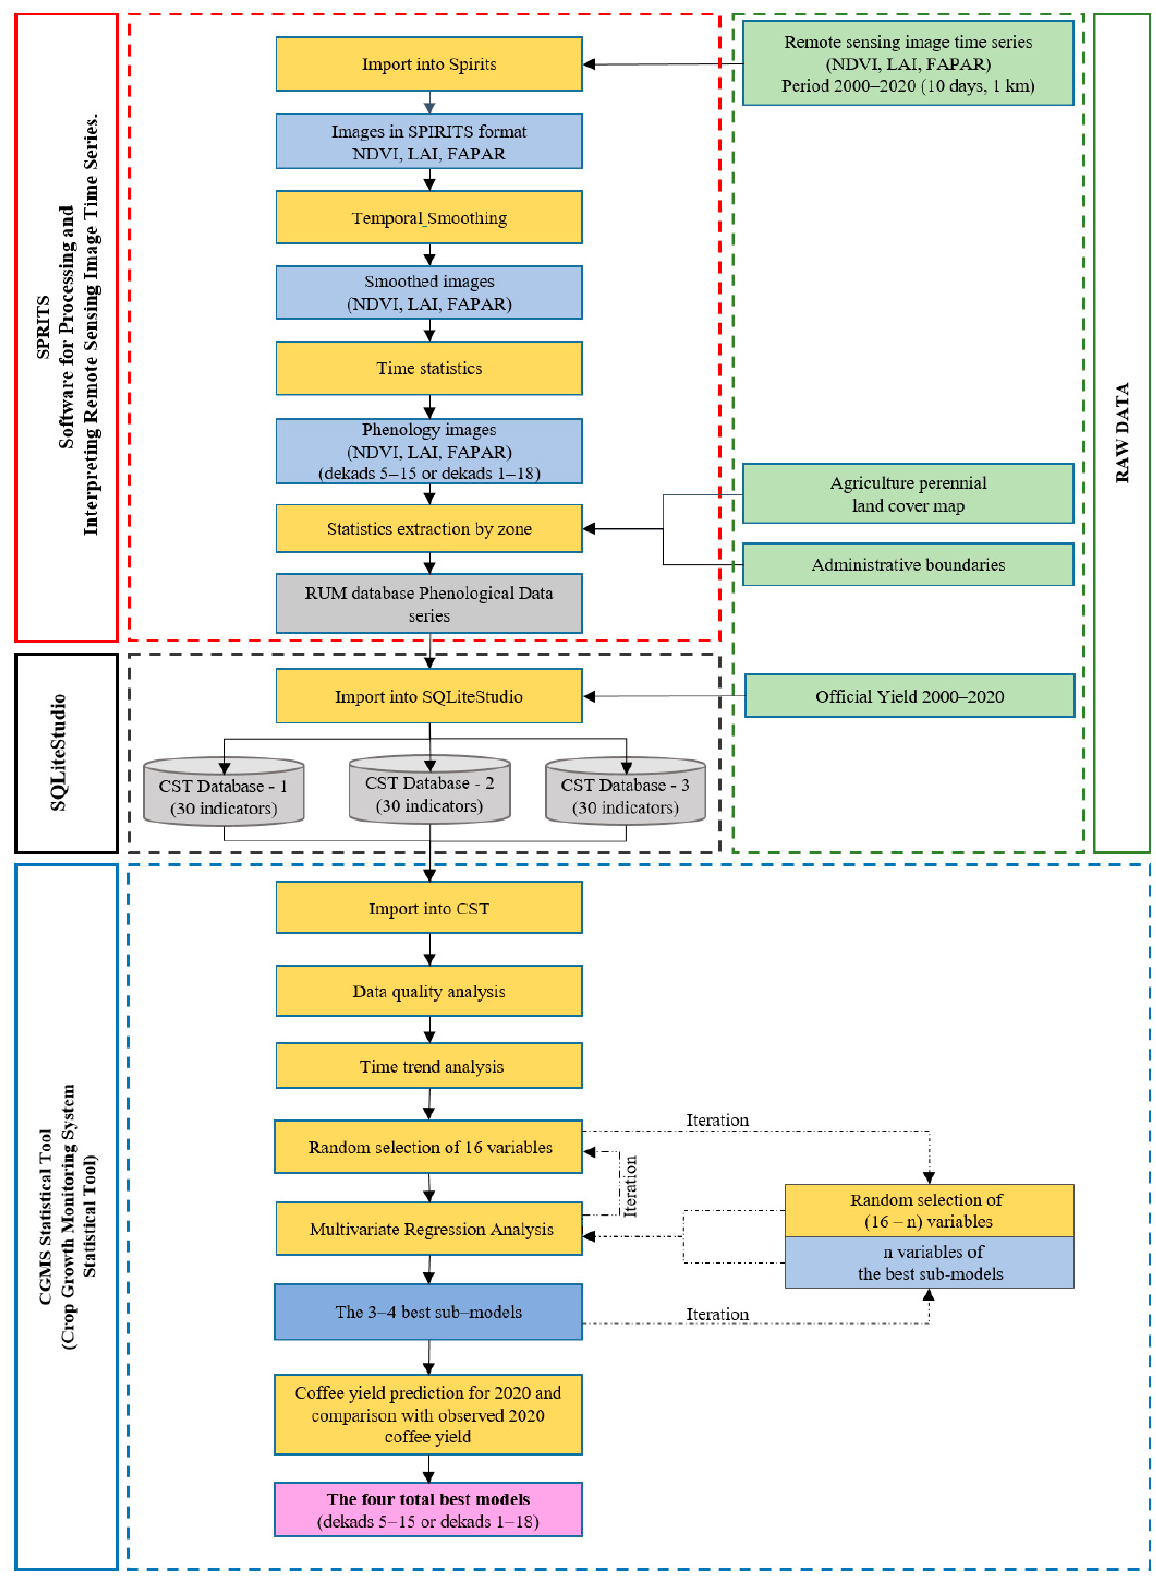
Figure 2. General workflow of the coffee yield forecasting method. Green rectangles: raw input data; yellow rectangles: data processing; blue rectangles: intermediate data; gray rectangles: variable databases; and pink rectangle: final results.